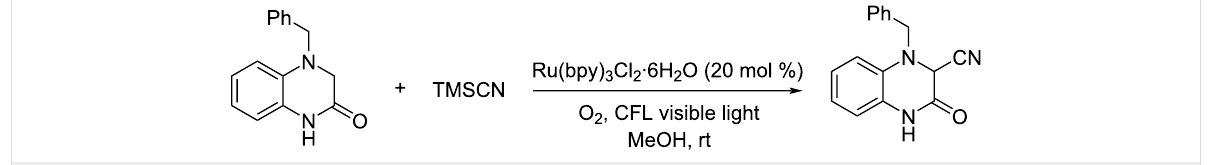
Scheme 19: Photoredox cross coupling